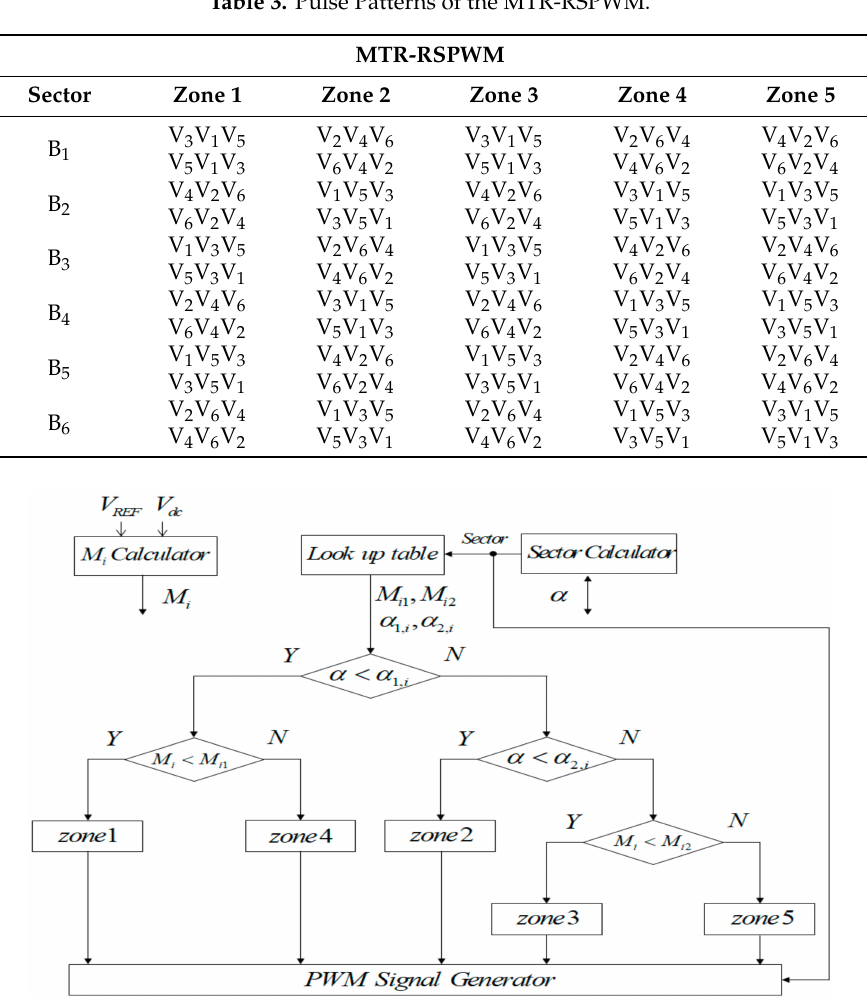
Figure 7. Block diagram of the